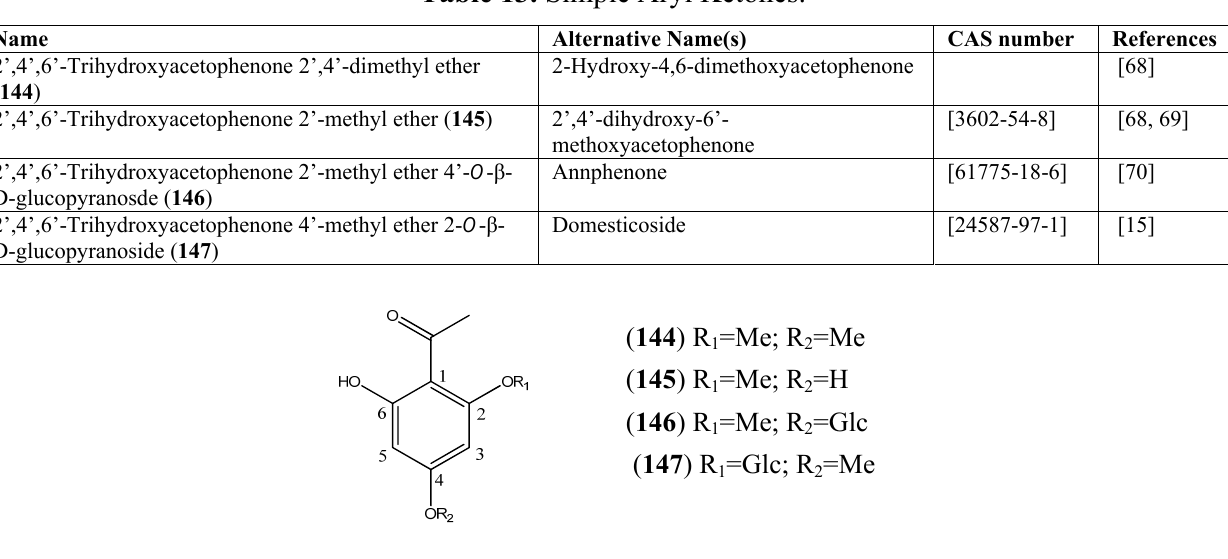
Table 13. Simple Aryl Ketones.